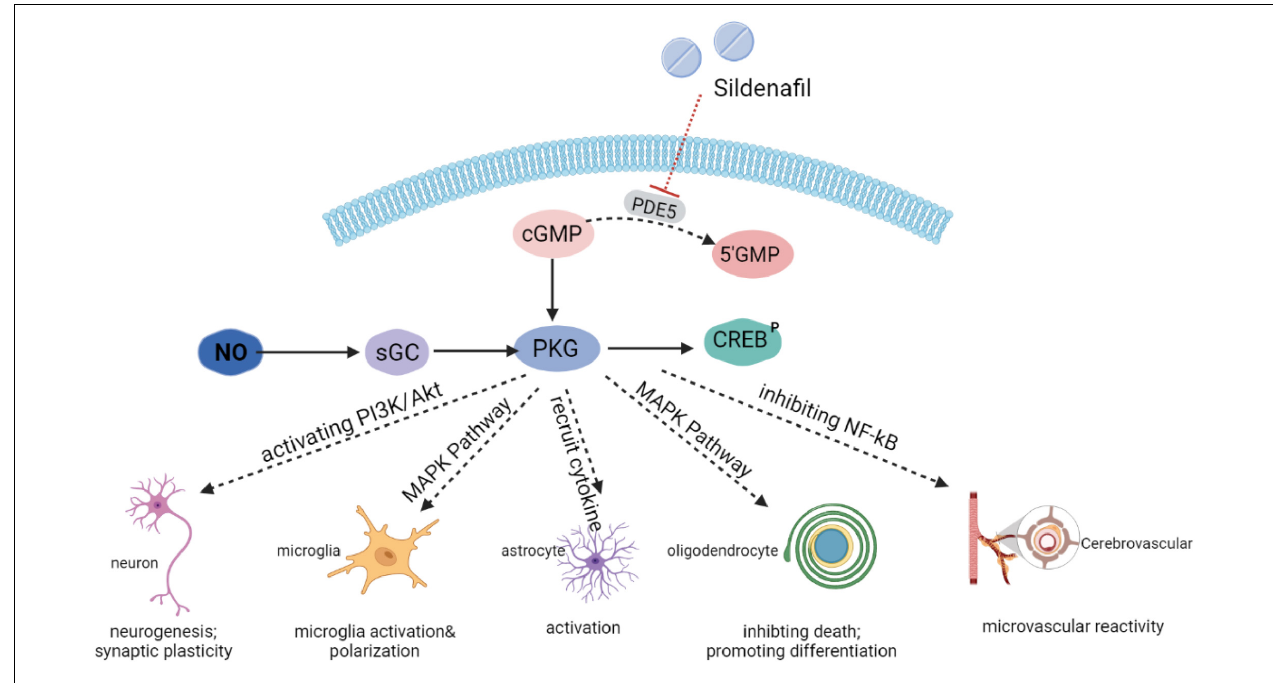
FIGURE 1 | Mechanisms of action of